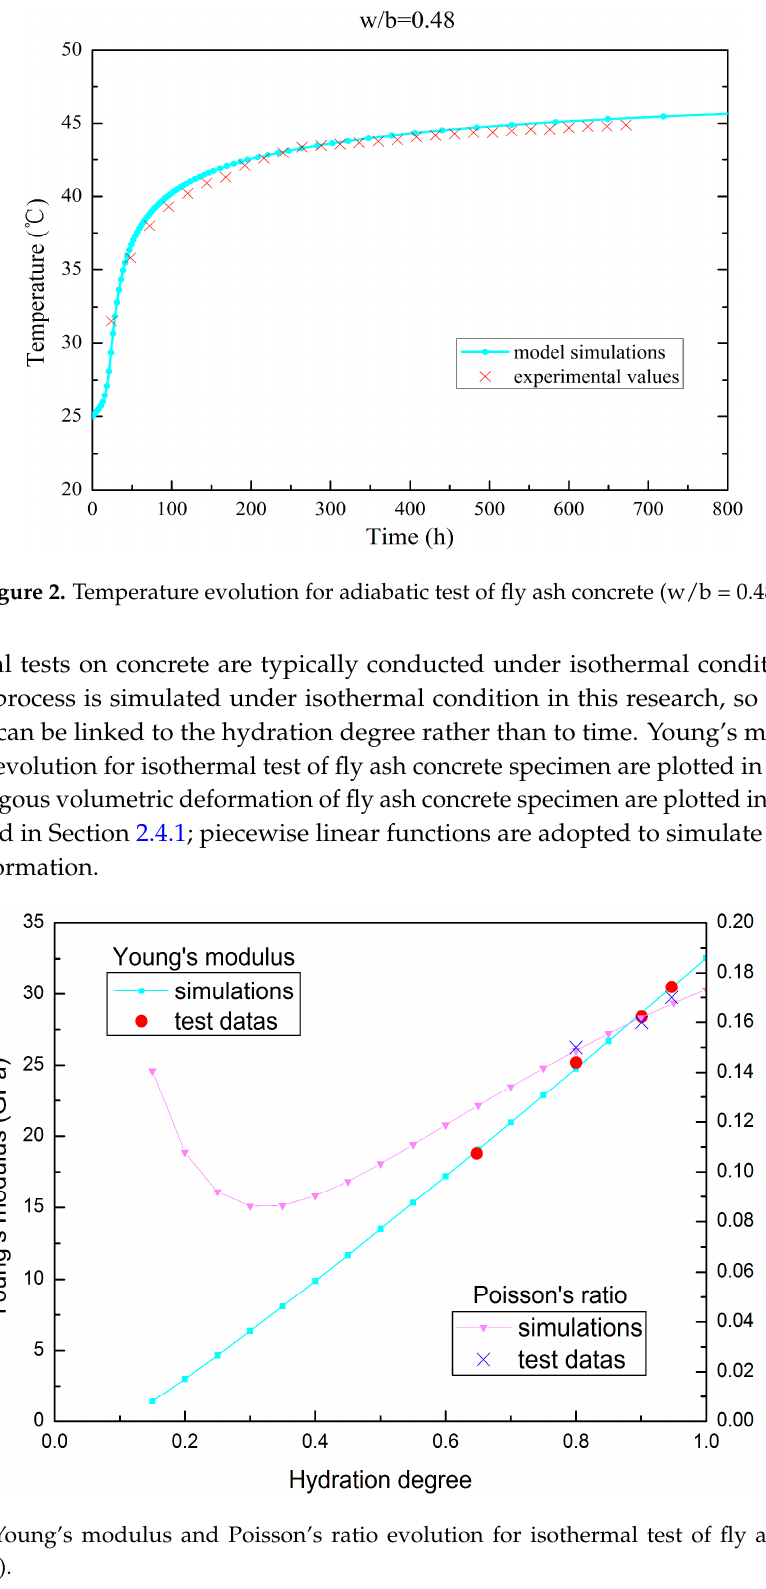
Figure 1. Temperature evolution for adiabatic test of fly ash concrete (w/b = 0.45).